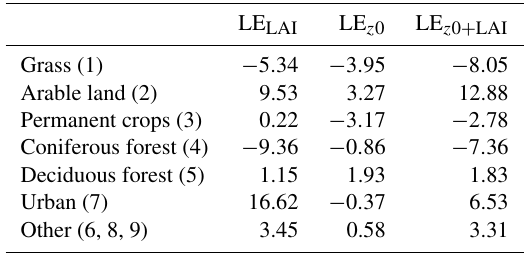
Table 7. Relative change (%) in total N r deposition with respect to the default run over Germany, the Netherlands and Belgium in 2014 per land use